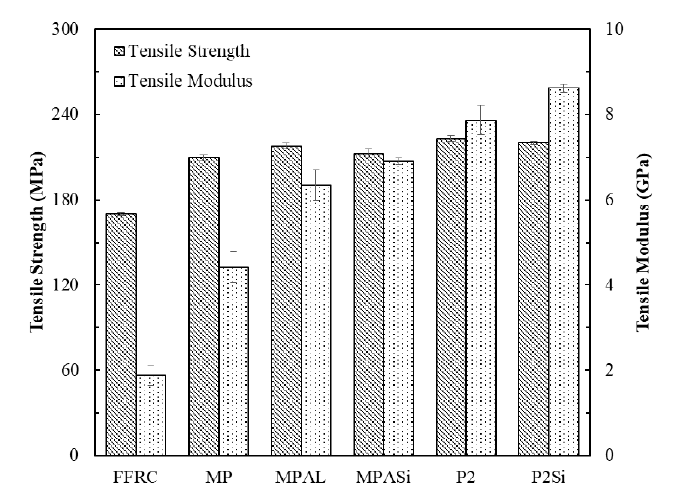
Figure 10. Tensile strength and modulus of FFRP and five types of modified FFMLs composites.